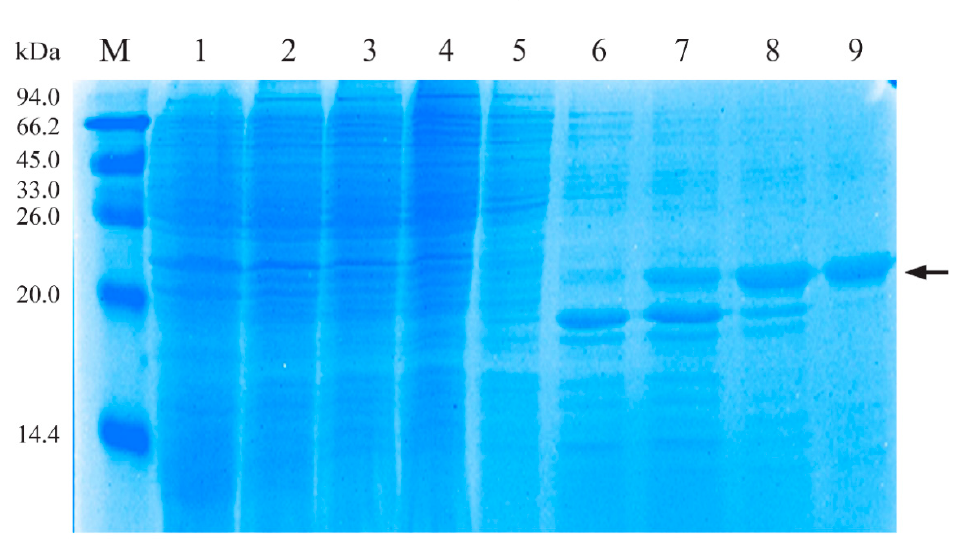
Figure 1. Characterization of recombinant His-PLO. Purification of His-PLO protein was detected with Coomassie-stained SDS-PAGE gels. M, protein marker; 1, total bacterial proteins not induced; 2, total bacterial proteins induced for 12 h; 3, supernatant from crushed cells; 4, flow-through solutions; 5–9, purified recombinant His-PLO protein by different concentrations of imidazole solutions (25 mM, 50 mM, 75 mM, 100 mM, 150 mM). Arrow on the right indicates the specific His-PLO band detected, which corresponds to the 21 kDa protein.